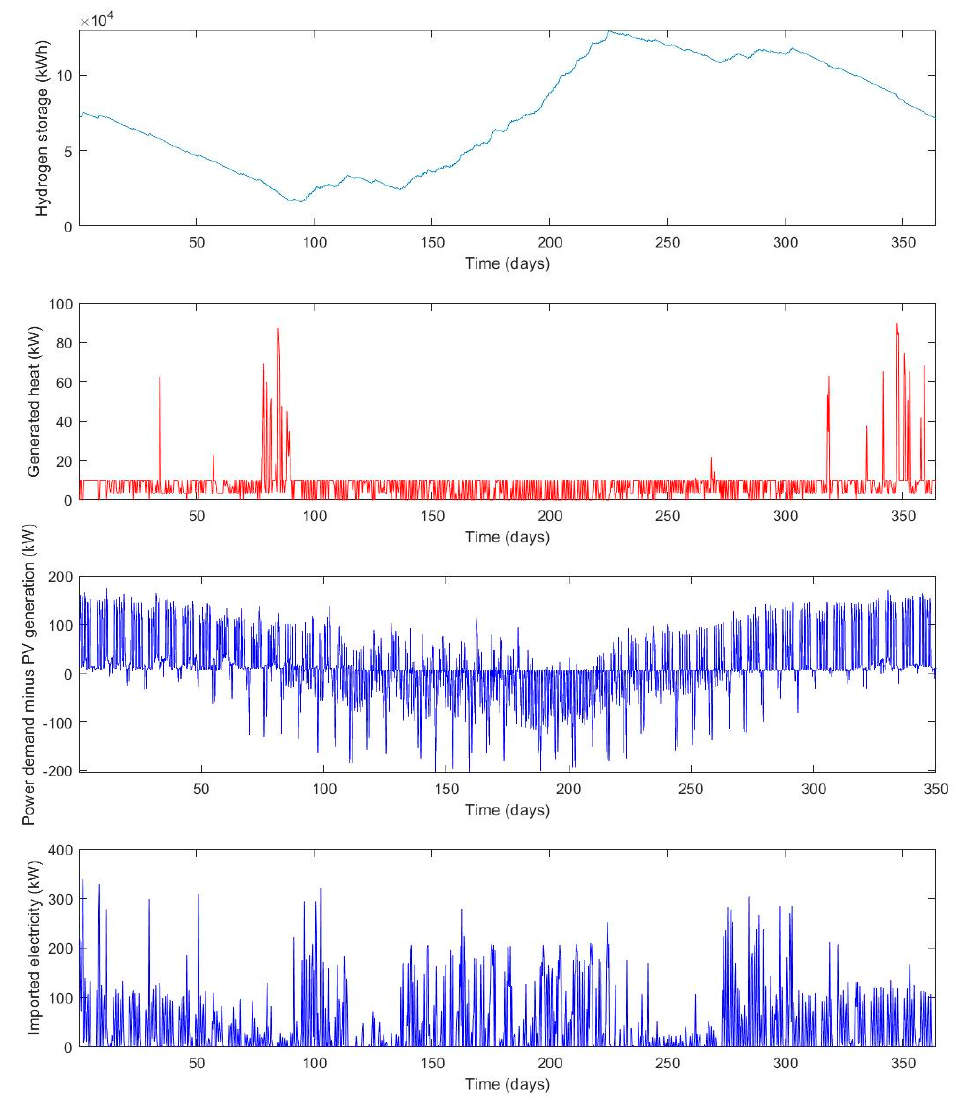
Figure A5. Optimal operation of a 50 / 200 kW RSOC system with 2000 m 2 solar PV panel.